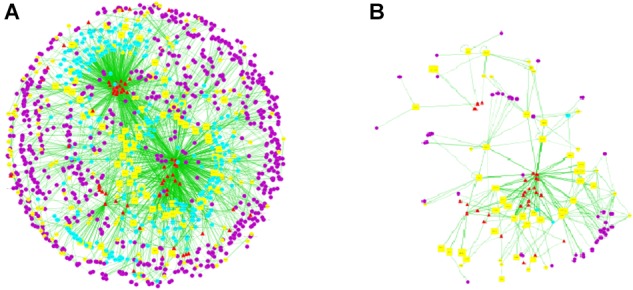
Compound-target-disease network of LRK. (A) The main network of “compound-target-disease” of LRK. (B) The sub-network with direct targets and the corresponding ingredients. Notes: The red triangles represent active chemical constituents of LRK, the blue dots represent the indirect targets for drugs, the yellow dots represent the targets of the specific disease of HMG, the yellow squares represent the common targets of herbs and HMG, and the purple dots represent the interactional proteins with the targets of HMG and drugs.